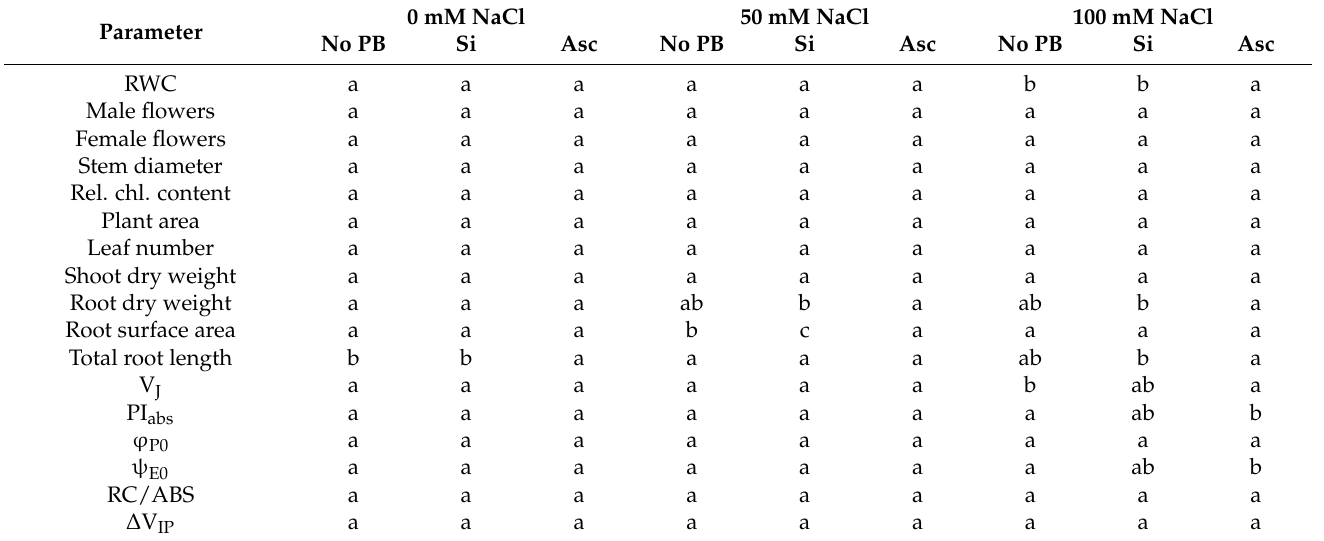
Table 2. Tukey post hoc statistical analysis of plant biostimulant (PB) applications within the different salinity levels. Within a row and a salinity level, different letters denote significant differences (a < 0.05). RWC: relative water